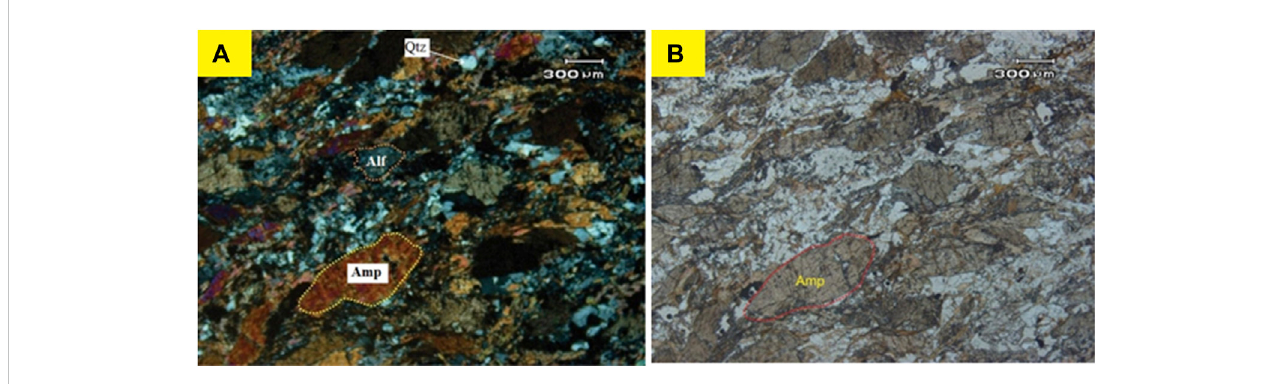
FIGURE 12 (A) XPLviewofsampleS13showingahighamountofamphibole(Amp)withalteredalkalifeldspar(Alf)andaminuteamountofquartz(Qtz)ontheleft. (B) Photomicrograph showing the PPL view of sample S13 on the right.